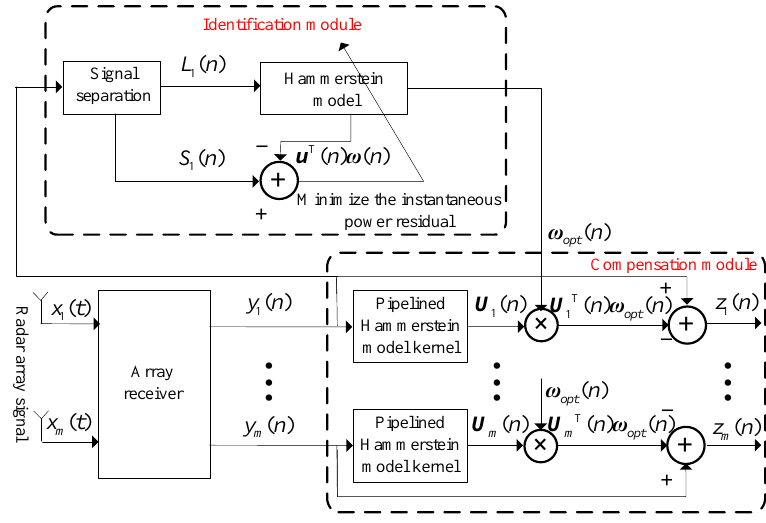
Figure 3. Proposed nonlinear blind mitigation structure for the array receiver.